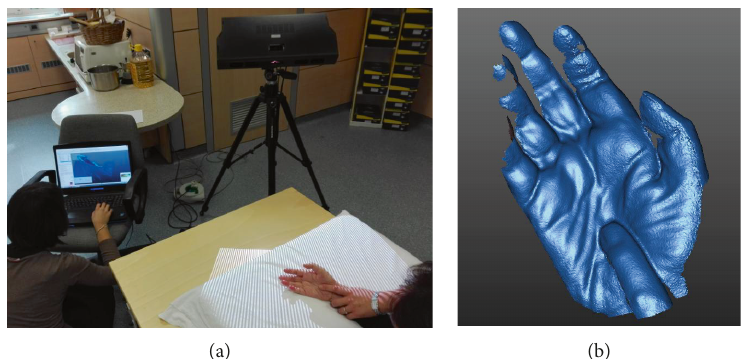
Figure 2: Hypotonic patient: (a) 3D scanning and (b) acquired data.